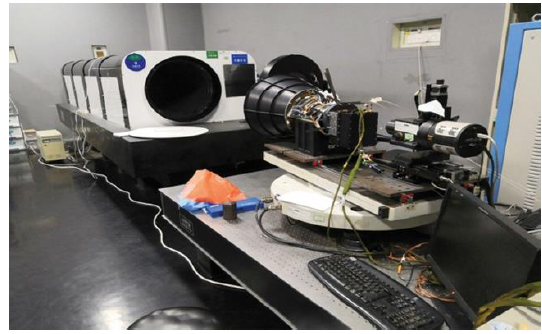
Figure 9. Experimental measurement device used to measure the size of diffuse spot.